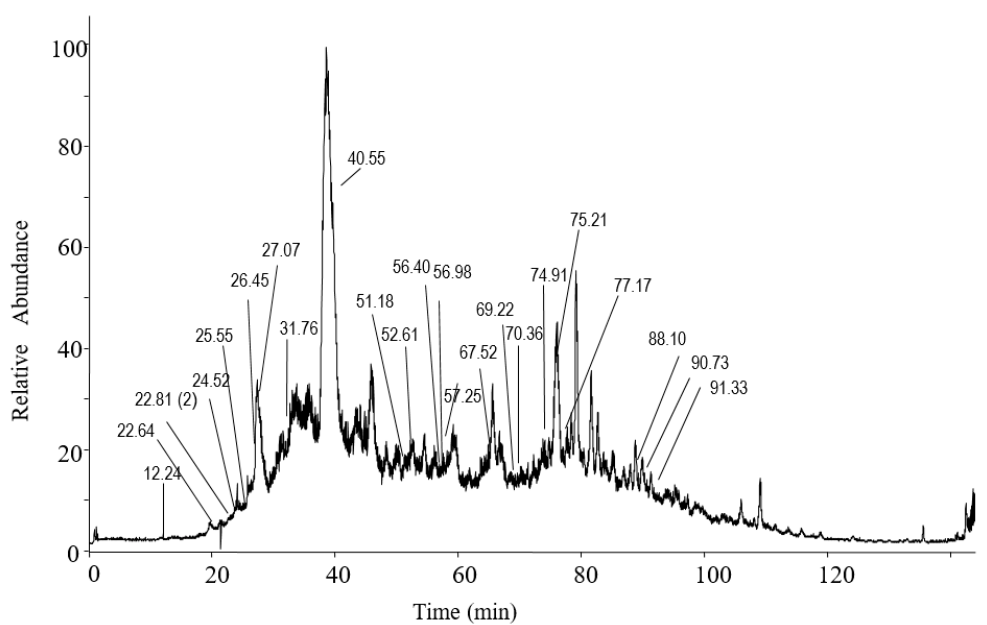
Figure 3. Analysis by nano- LC-Orbitrap MS / MS of water-soluble peptides extracted from unfiltered virgin olive oil. The total ion chromatogram and retention times of the selected ACE inhibitory peptides are shown. Brackets show the number of peptides with the same retention time.